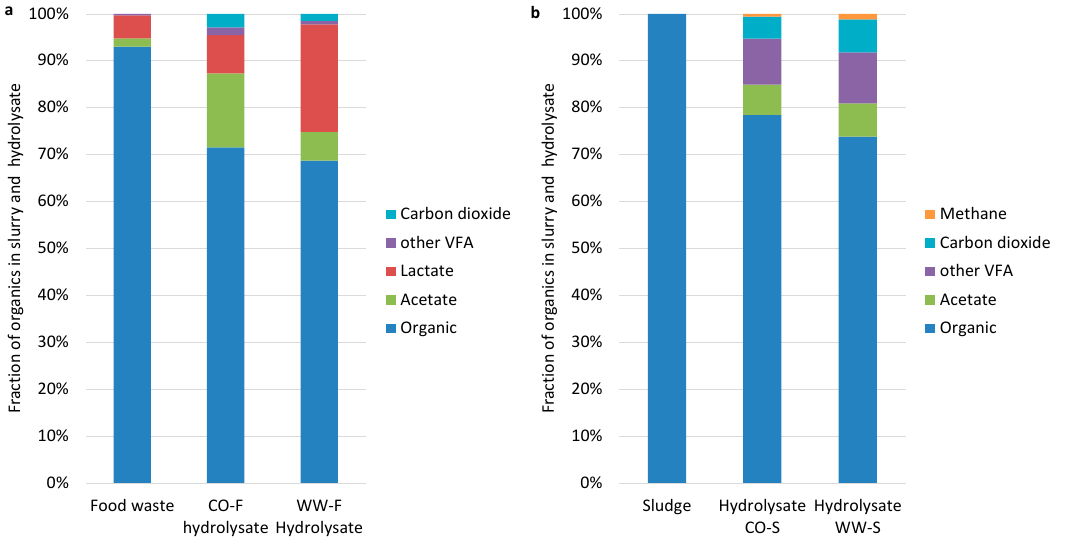
Figure 3. Composition of ingoing substrate and outgoing hydrolysate from reactors fed ( a ) food waste (CO-F, WW-F) and ( b ) sewage sludge (CO-S, WW-S). Mass of outgoing gases is included in the hydrolysate.